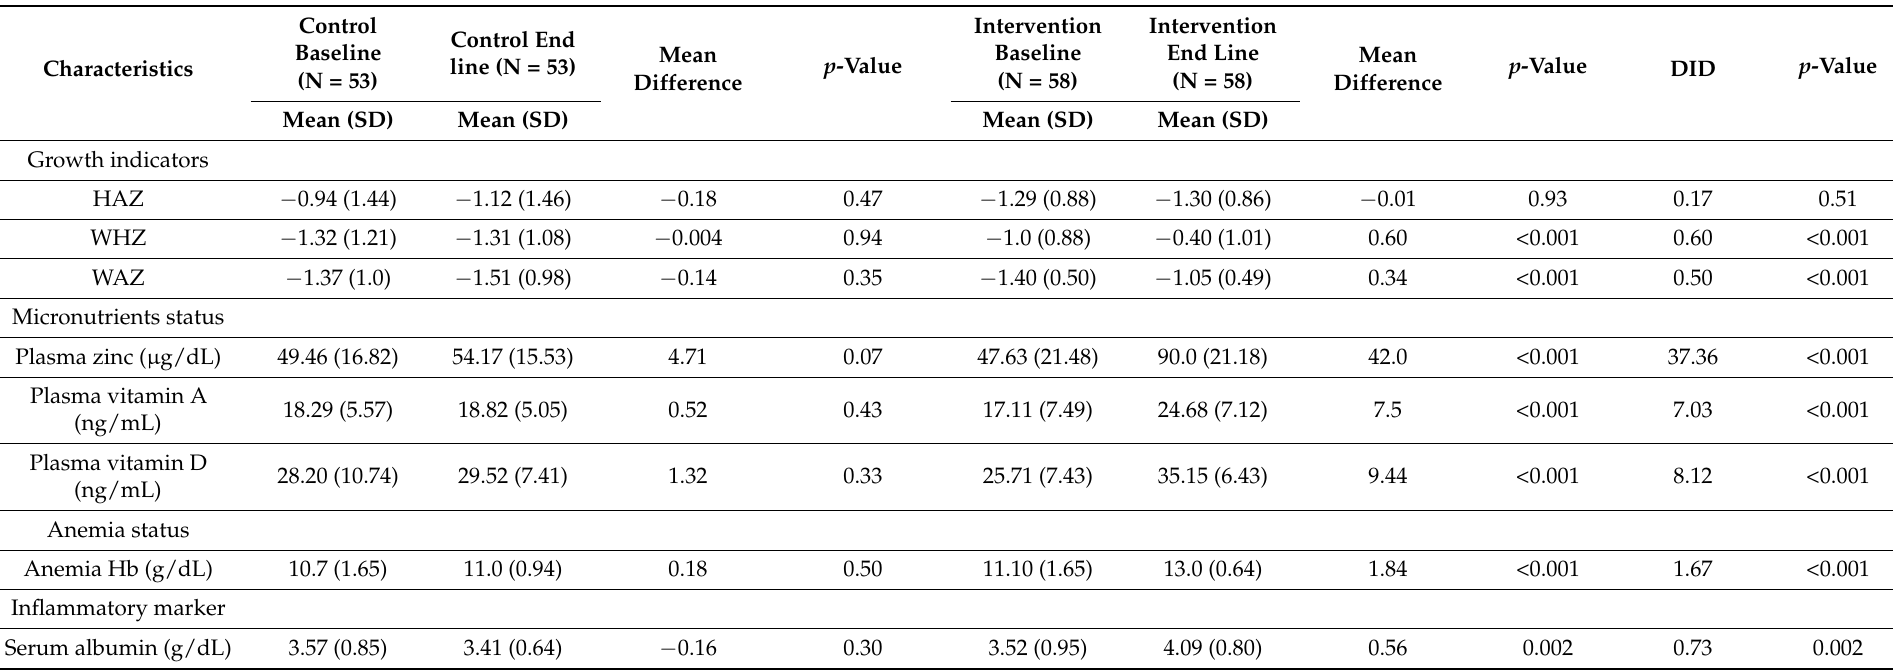
Table 3. Comparison of plasma micronutrient status, anthropometric outcomes, hemoglobin level, and inflammatory biomarker of children at the baseline and end line by study